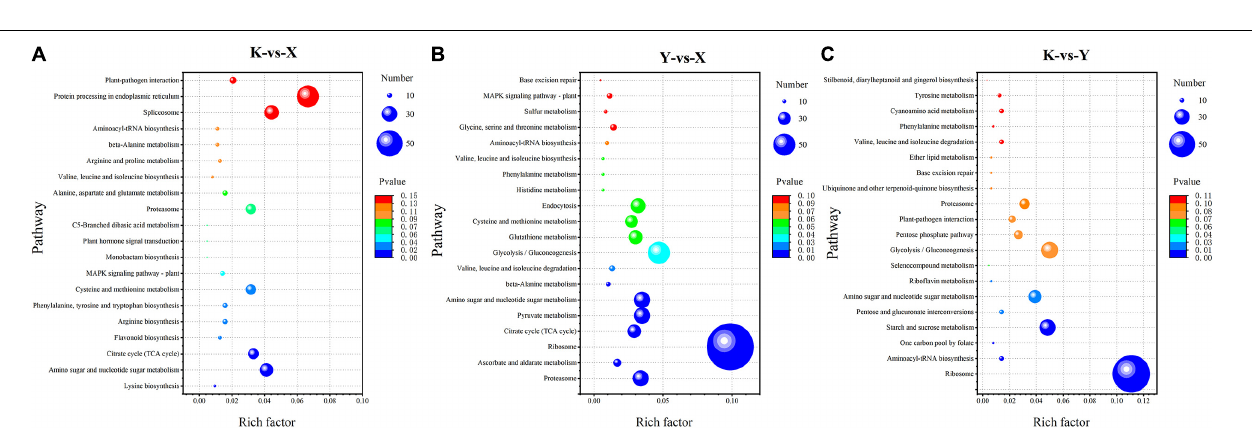
FIGURE 7 | Scatterplot of the KEGG pathway enrichment statistics of DAPs. (A) Shade-drying vs. fresh. (B) Smoke-drying vs. fresh. (C) Shade-drying vs. smoke-drying.